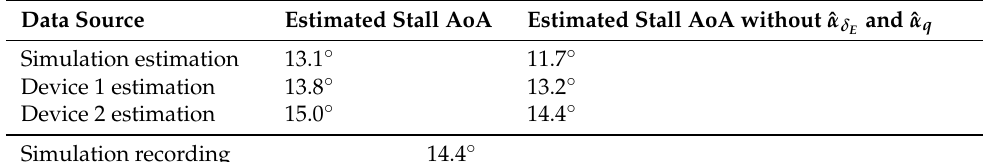
Figure 10. The effect of each term in Equation (6) on the AoA estimated from Device 1. Table 4. The stall AoA in the test flight and flight simulator in the stall with idle power